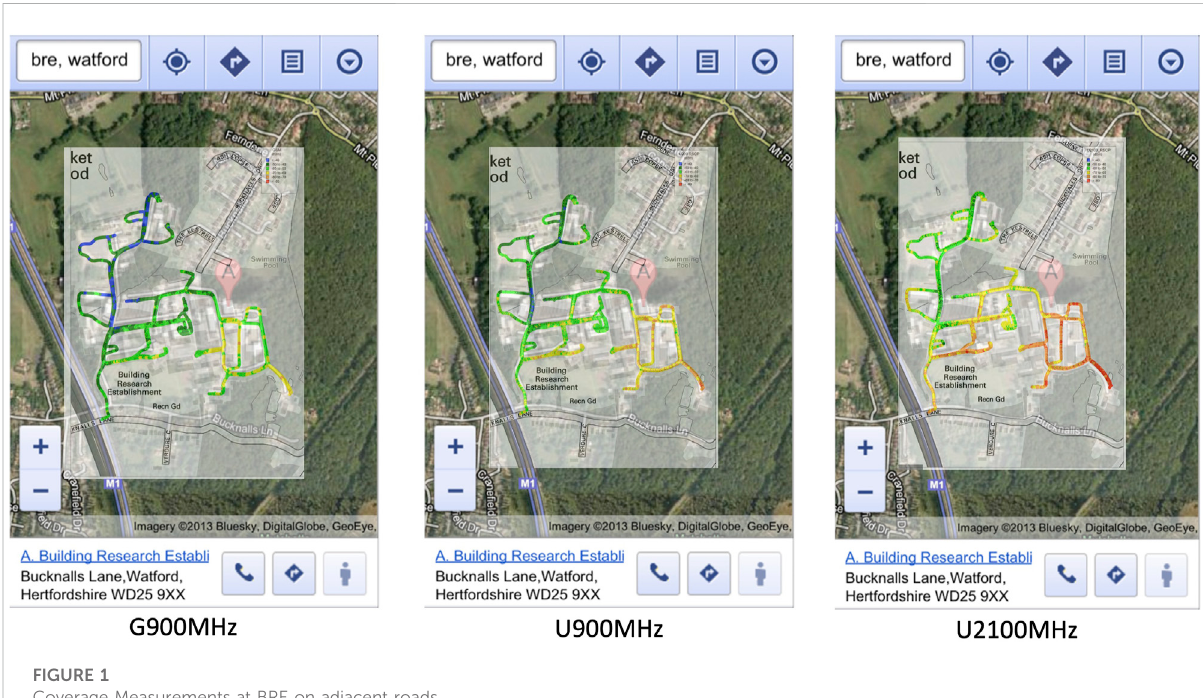
FIGURE 1 Coverage Measurements at BRE on adjacent